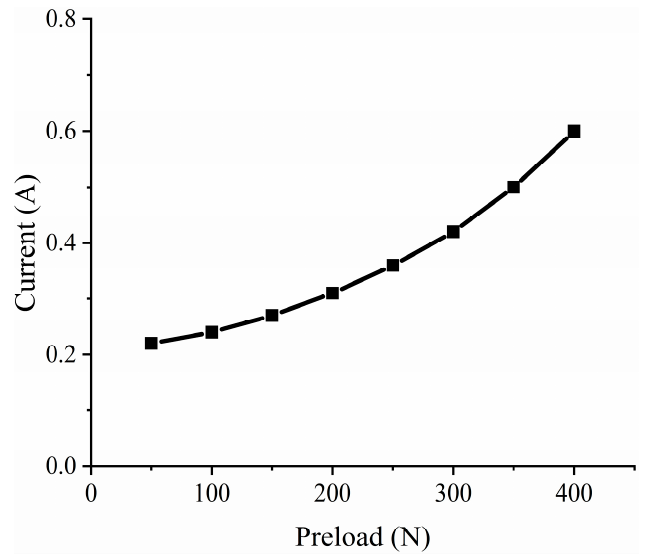
Figure 6. Current variation at different preloads.